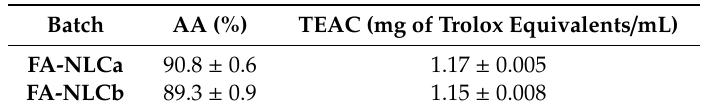
Table 4. In vitro antioxidant activity (AA) of FA-loaded NLC prepared using IPM (FA-NLCa) or Lavandula EO (FA-NLCb) as oily phase. DPPH results are expressed as AA (%) and as TEAC (mg / mL) concentration. Results are reported as the mean value ± SD of three separate experiments, each performed in